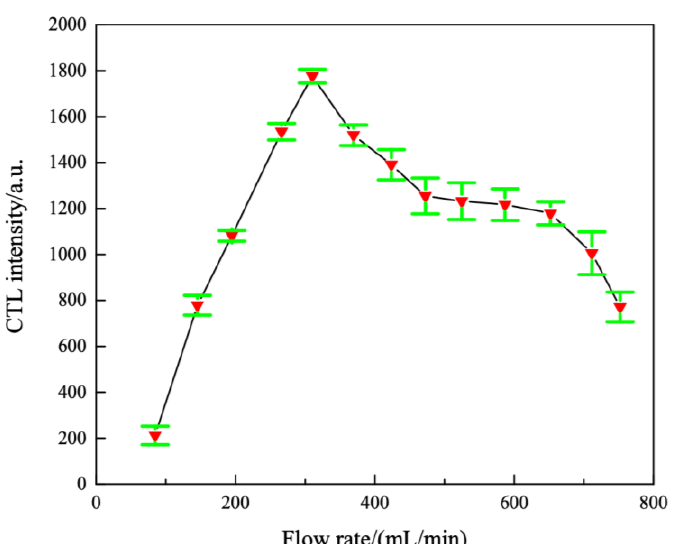
Figure 5. Selection of the optimal carrier gas flow rate (temperature: 220 °C, wavelength: 425 nm, concentration: 200 ppm).